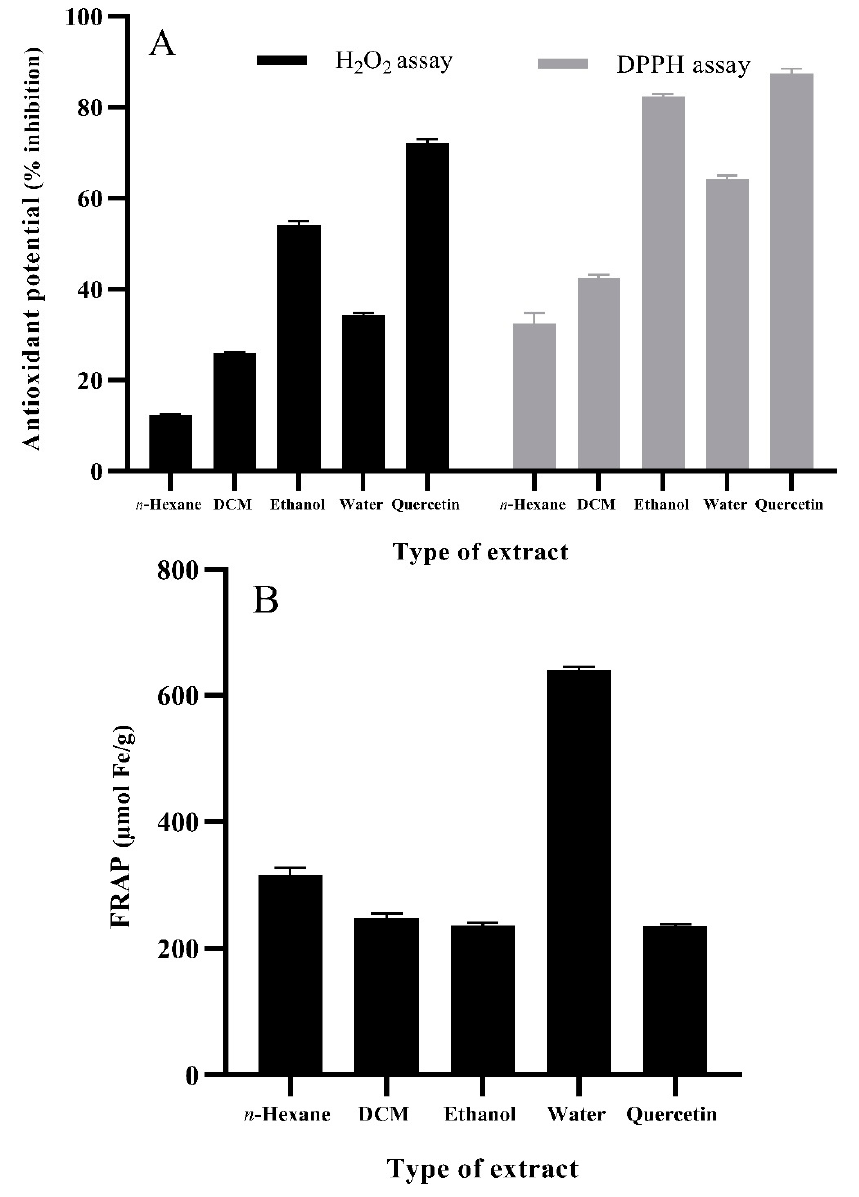
Figure 2. Antioxidant potential of different solvent extracts of basil ( O. basilicum : 50 mg/mL; positive control quercetin: 125 µ g/mL): ( A ) H 2 O 2 and DPPH assay; ( B ) FRAP assay. Values are means ± S.D. DCM, dichloromethane.